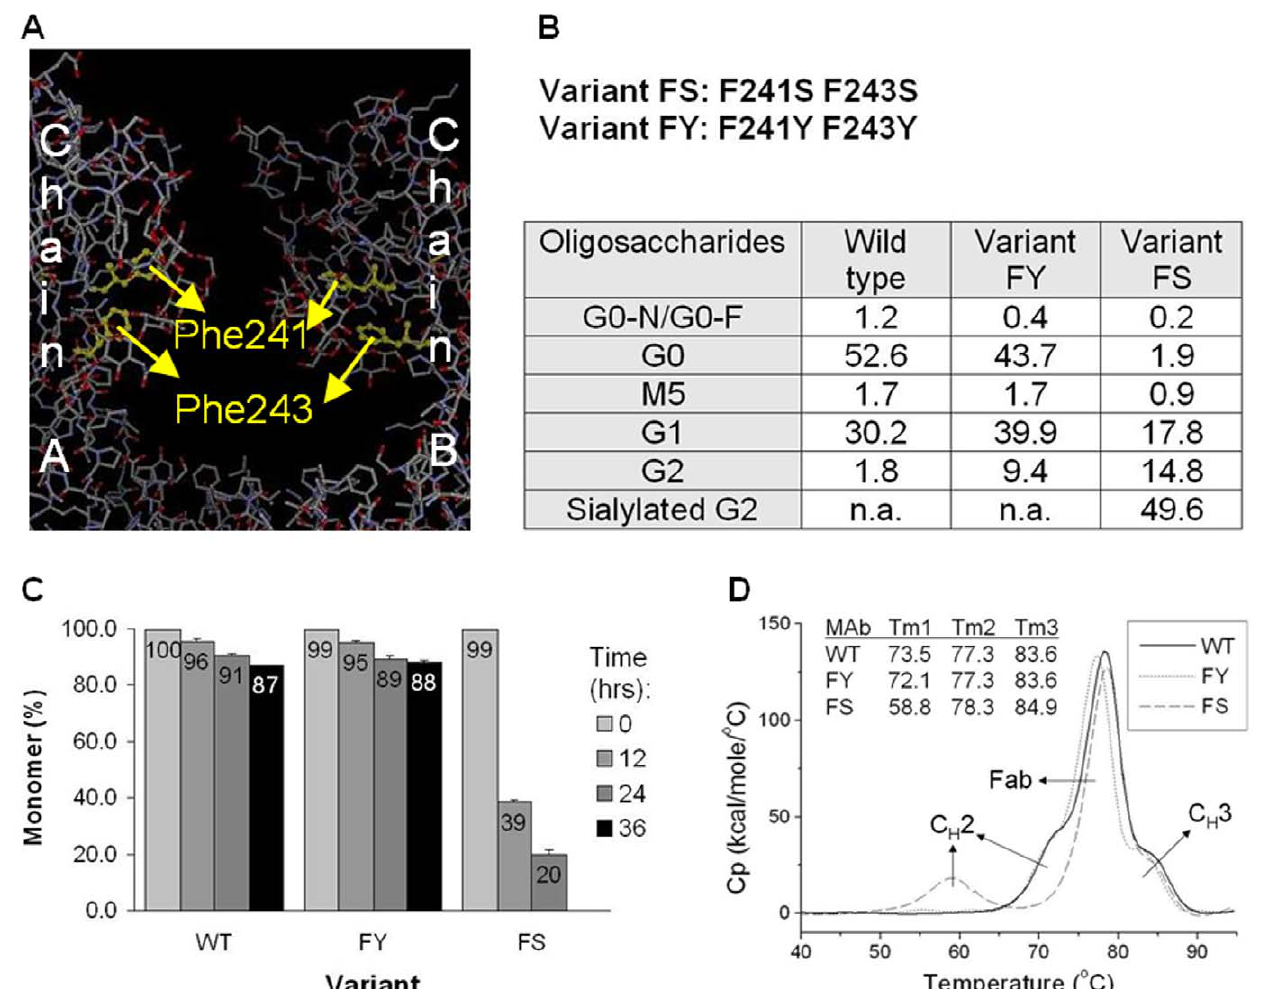
Figure 4. The IgG1 variants F241S F243S (FS) and F241Y F243Y (FY) illustrate the importance of CH-pi interactions for stability of the C H 2 antibody domain. (A) Close-up on the C H 2 domain showing the location of the mutated residues on the inner side of C H 2, and the alignment of Phe241 and Phe243 aromatic rings with sugar rings. (B) Glycosylation profile of wild type and the two F241 F243 variants. The percentage of the predominant glycoforms is listed. (C) Accelerated aggregation of wild type and variants at 58 u C for the indicated time. Percent monomer at each time point was calculated from SEC-HPLC analysis. (D) DSC thermograms of wild type and Variants FY and